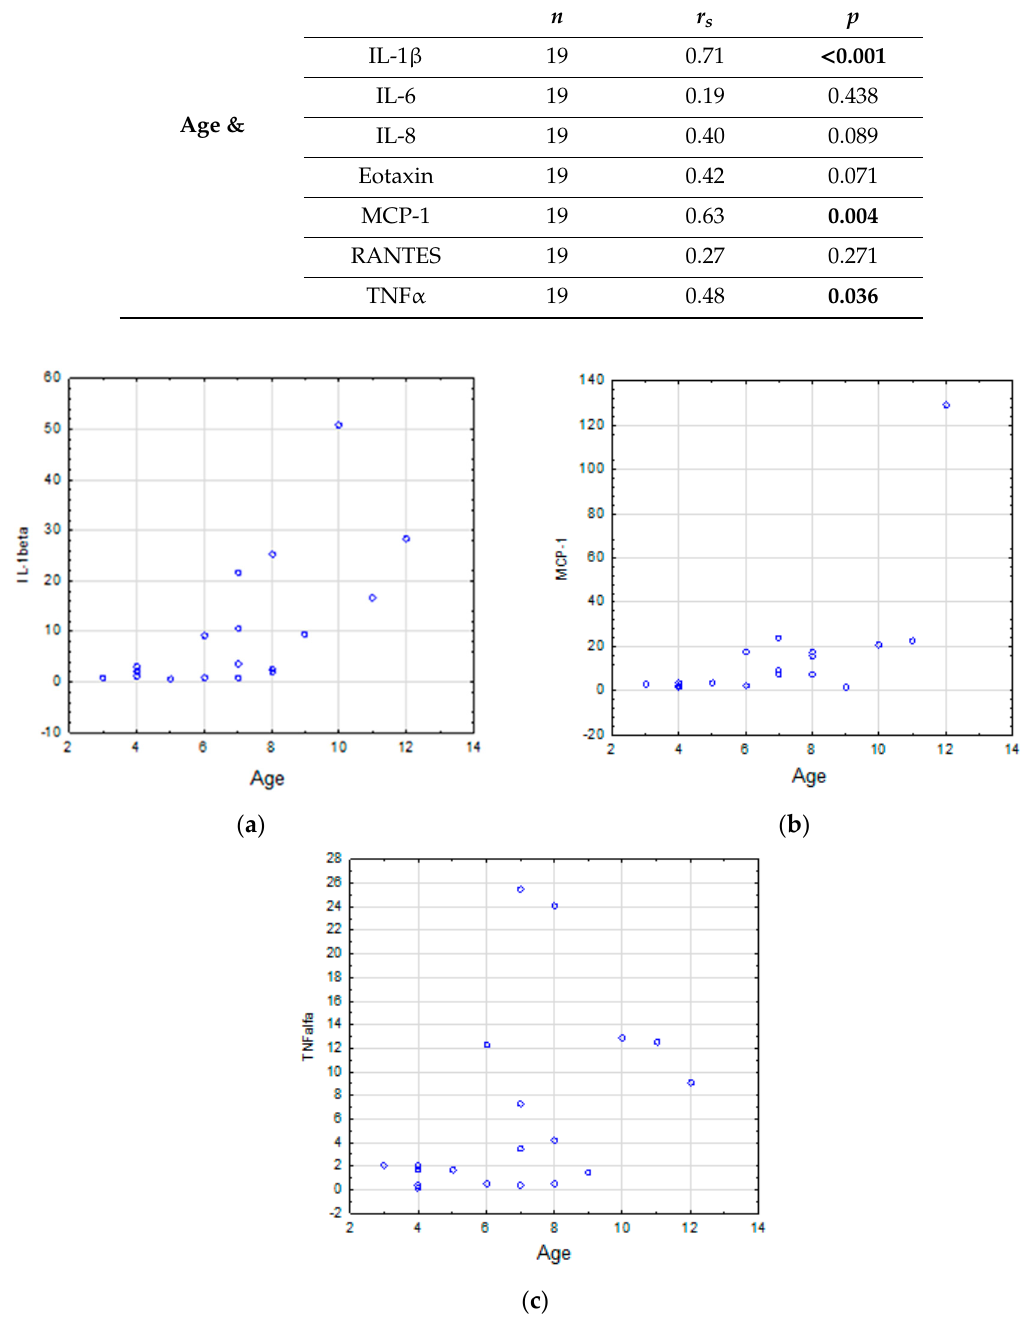
Table 6. Correlations between IL-1 β , IL-6, IL-8, eotaxin, MCP-1, and TNF α salivary levels and the age in the TDs group. The strength of the correlations was determined using Spearman’s rank correlation coe ffi cient; p < 0.05 was considered statistically